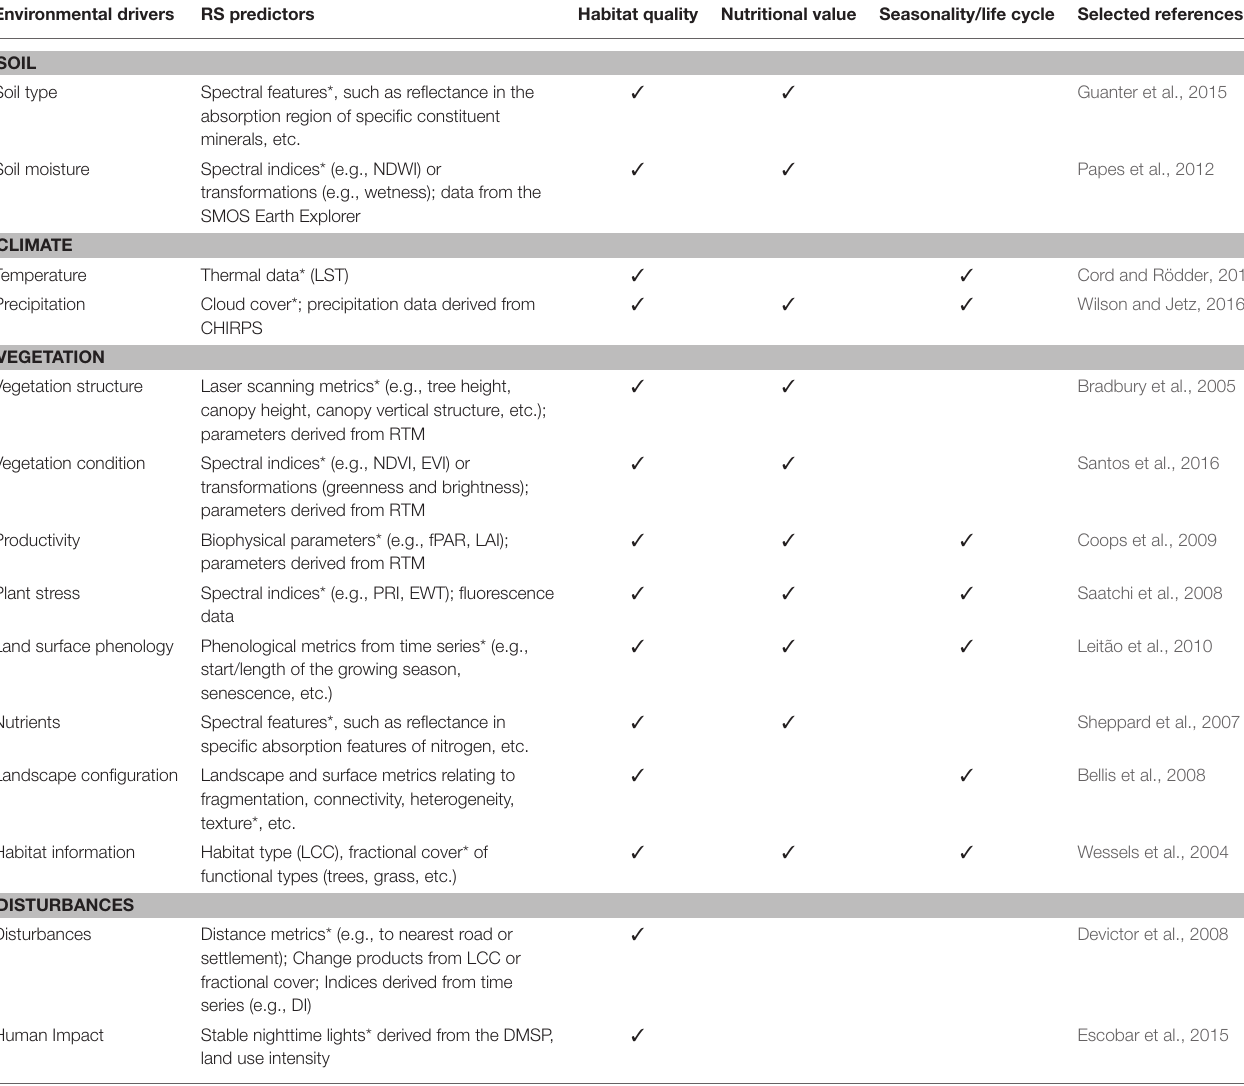
TABLE 1 | Potential RS variables for describing three axes of a species ecological niche: habitat quality, nutritional value, and seasonality and life cycle. Environmental